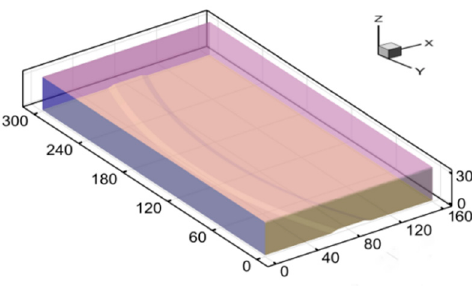
Figure 1. CFD model of embankment.